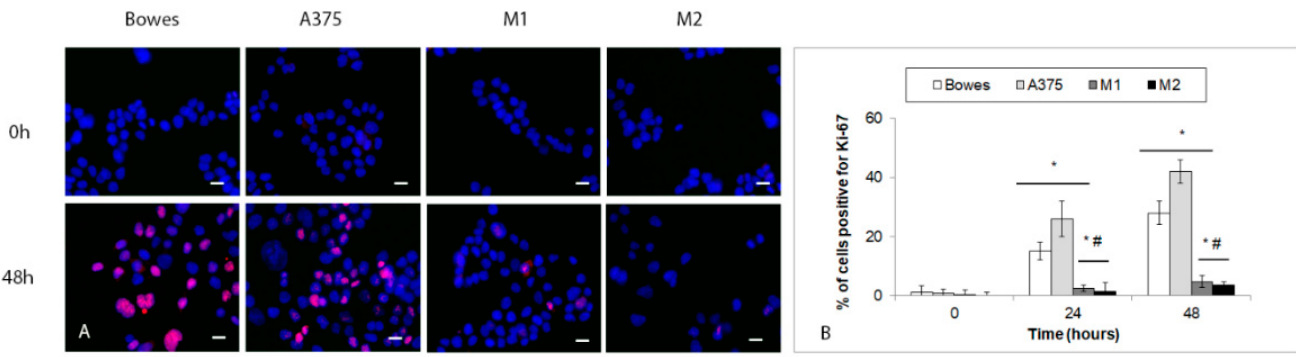
Figure 10. Cell cycle arrest in free zinc depleted human melanoma cells Bowes and A375 and melanoma explant cultures M1 (low free zinc) and M2 (high free zinc) treated to standard growth medium supplemented with 100 µ M zinc sulfate during 48 h. In exposed cells Ki-67 positivity was determined by immunofluorescence. ( A ) Fluorescent microscopy, 200 × . Scale bar 2 µ m. Blue—DAPI; red—Ki-67. Results represent means ± SD of at least three independent experiments. ( B ) Quantification of Ki-67 positivity. Results represent means ± SD of at least three independent experiments. p < 0.05 * Significantly higher compared to the beginning of treatment, p < 0.05 # Significantly lower than Bowes and A375 cells at the same time interval with one-way-Anova test and Dunnett’s post test for multiple comparisons.